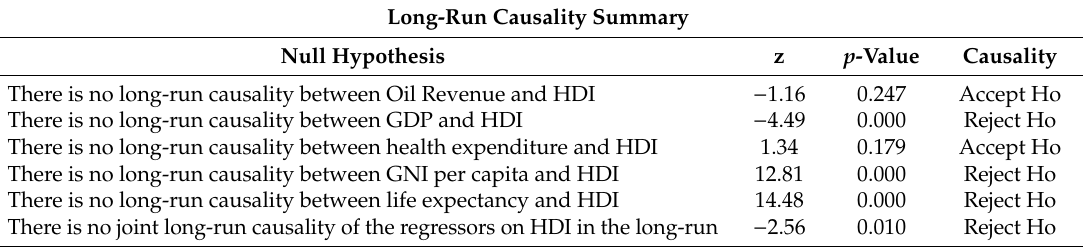
Table 14. Long-run causality